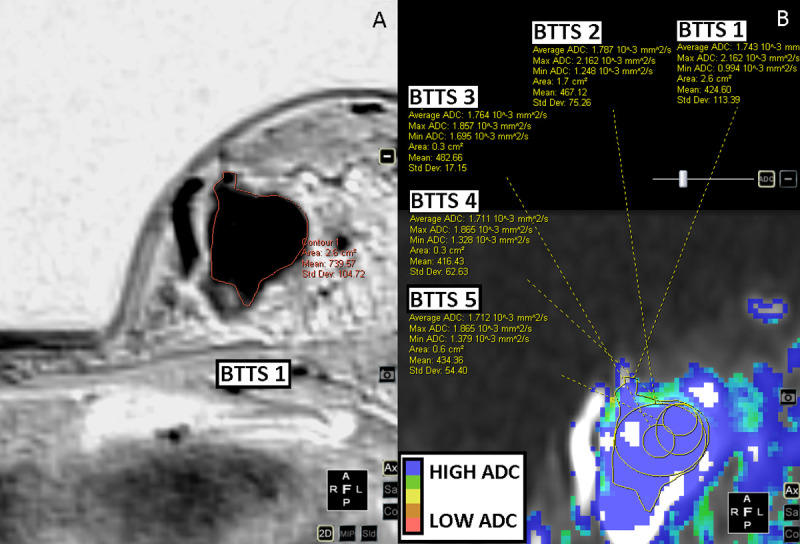
Benign phyllodes tumor of the left breast.DCE-T1 subtracted images (inverted) (A) and DWI b0-1000 images (B).